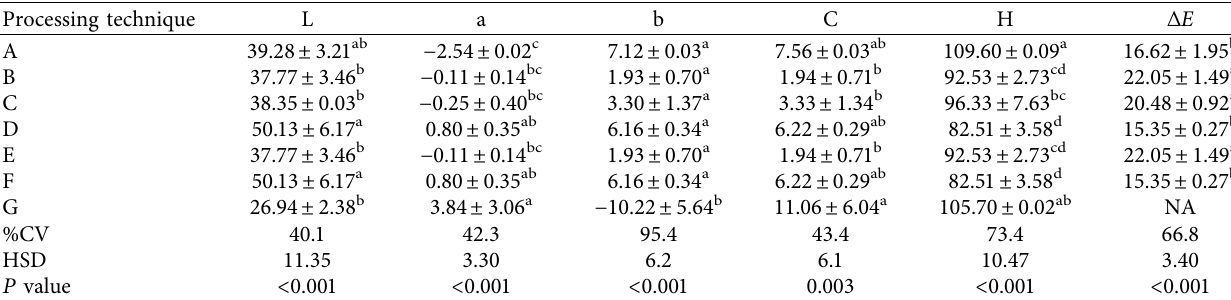
Table 13: Colour changes of optimally processed cowpea